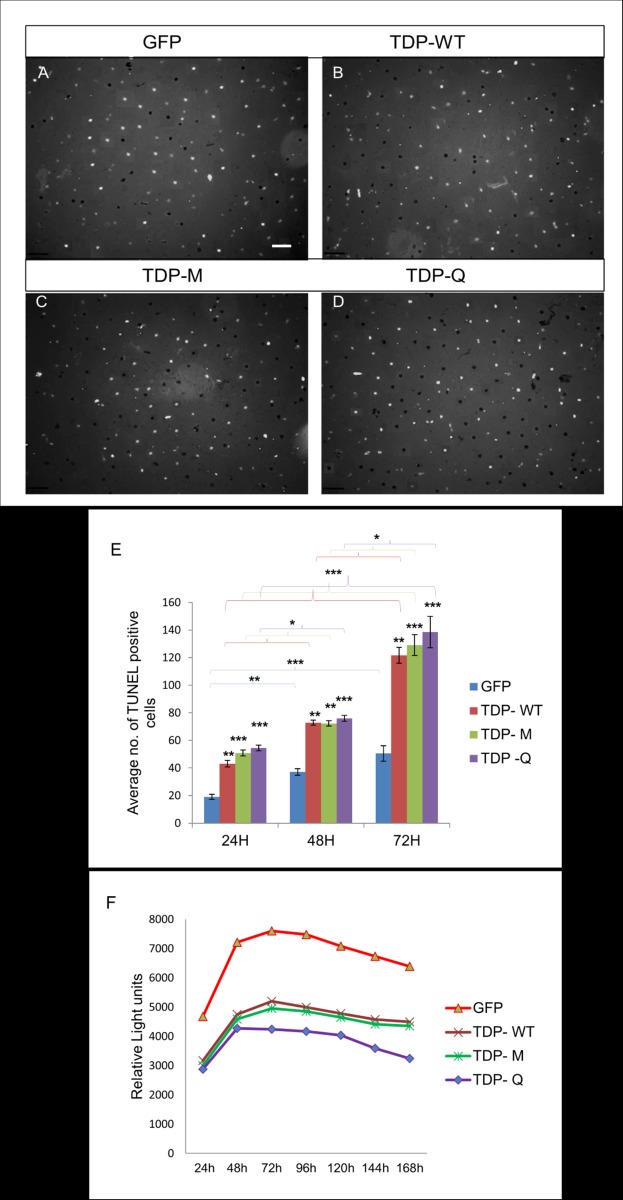
TDP-43 isoforms mediate toxicity in vitro.Control and TDP-43 transfected neurons (as labelled) were stained using a TUNEL kit and imaged to show TUNEL-positive cells (black dots) and Hoechst staining (white dots) after 72H in culture (A—D). Scale bar = 10 µm. (E) Average number of apoptotic cells quantified from five 0.24mm2 fields, at 3 time points as shown (3 experiments). Data is presented as means and standard errors. Significance was compared by ANOVA with GFP control at the respective timepoint and between constructs at various timepoints (no significance: p > 0.05; *** P < 0.0001, ** P < 0.001, * P < 0.01—compared with GFP control). (F) Semi-quantitative analysis of the viability of transfected cells assessed by Promega real-time glo viability assay at different time points from 3 experiments.